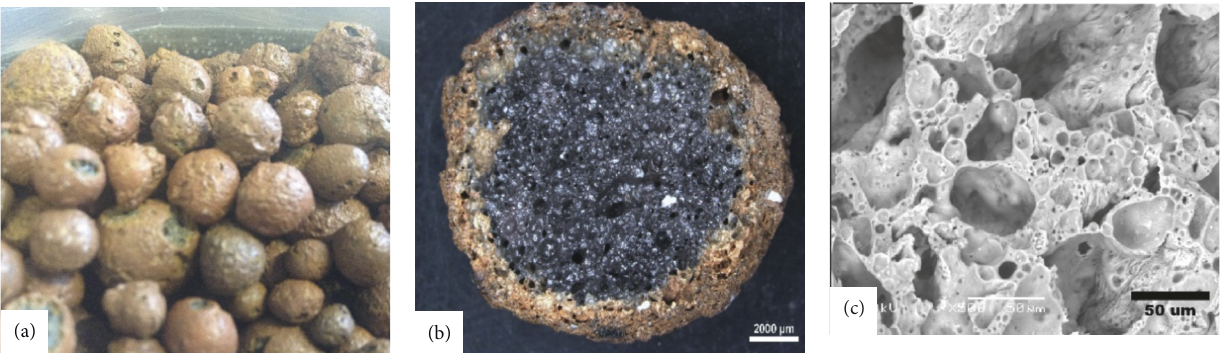
Figure 3: LWA aliven: (a) real scale; (b) micrograph to 32x and (c) SEM micrograph to 500x.